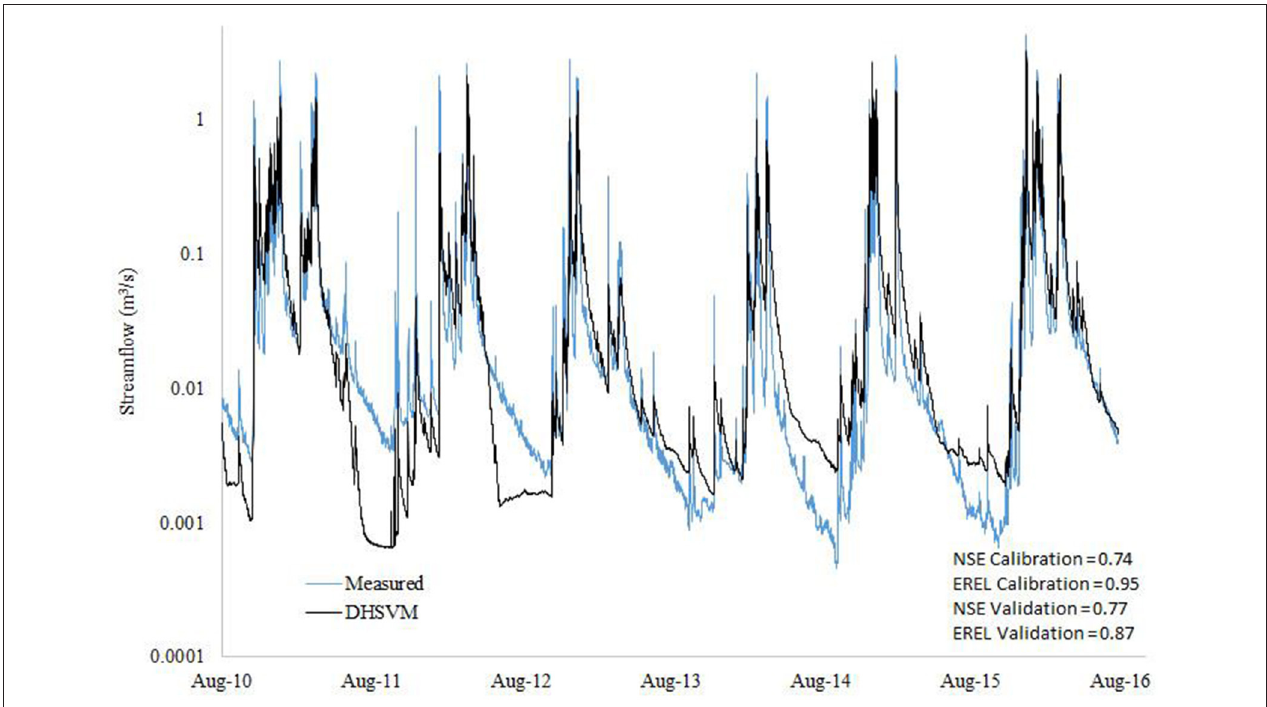
FIGURE 2 | Comparison of streamflow simulated by DHSVM and measured streamflow at the South Fork of Caspar Creek weir HY 2011–2016 and model fit statistics for the calibration period, 2011–2013 HY, and the validation period, 2014–2016 HY.